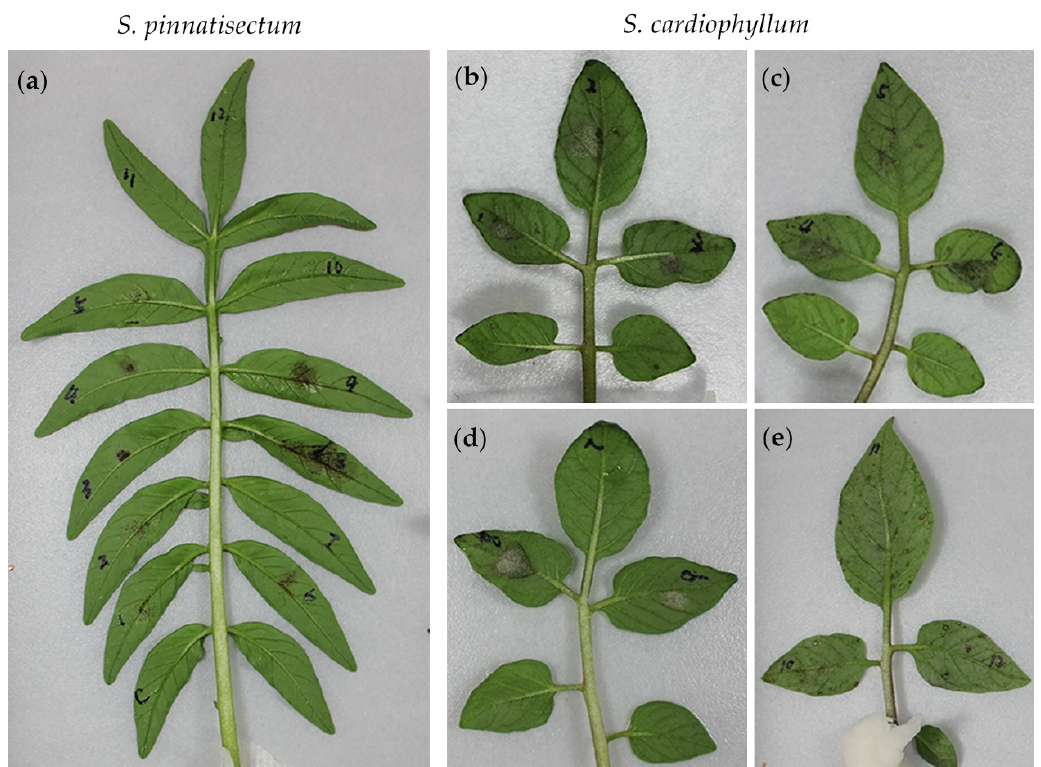
Figure 3. Symptoms on Solanum pinnatisectum and S. cardiophyllum leaves inoculated with 12 isolates of Phytophthora infestans 4 days post-inoculation. ( a ) Symptoms on a leaflet of S. pinnatisectum inoculated with 12 isolates of P. infestans . ( b ) to ( e ) Symptoms on leaflets of S. cardiophyllum caused by 12 isolates of P. infestans . C: water control. The virulence spectrum of these 12 P. infestans isolates are described in Table 2.